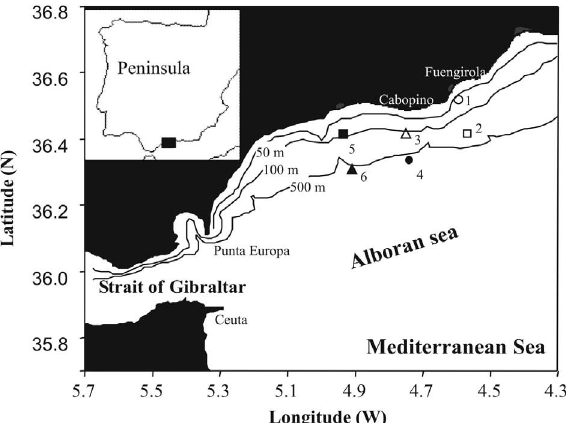
Fig . 1. – Map of the study area showing the sampling stations (sta- tion 1: open circles; station 2: open squares; station 3: open trian- gles; station 4: closed circles; station 5: closed squares; station 6: closed triangles). The contour lines indicate the bathymetry.